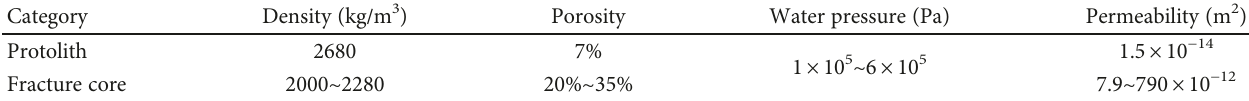
Table 2: Model parameters.